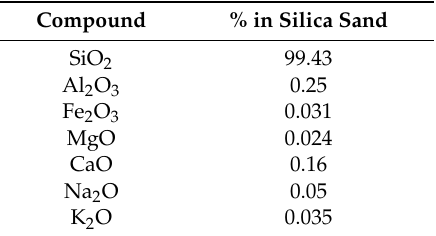
Table 1. Chemical composition (wt.%) of Saudi silica sand.